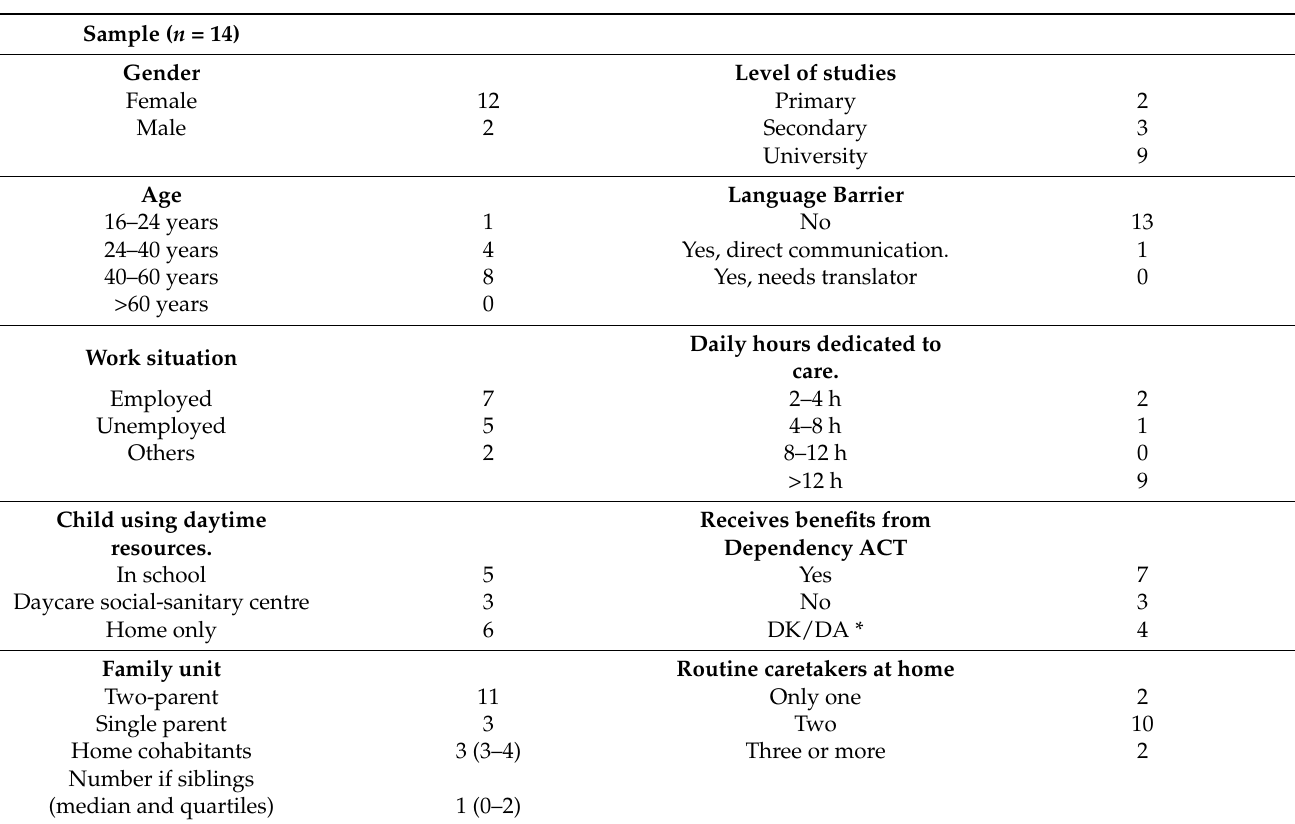
Table 4. Sociodemographic characteristics of the parents participating in the program (main caretakers) and family organization around child’s